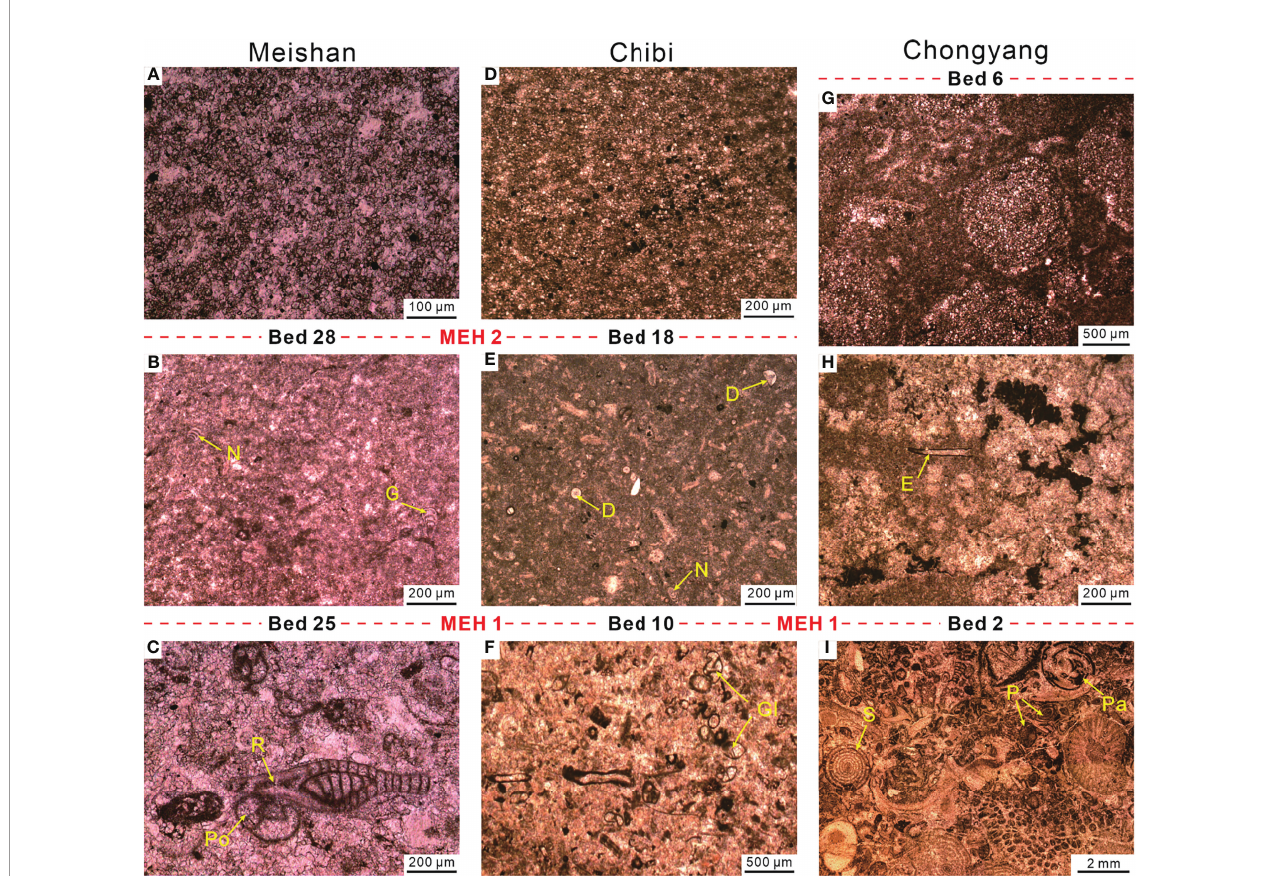
FIGURE 13 | Comparison of foraminifera features between Meishan (A – C) , Chibi (D – F) , and Chongyang (G – I) sections. (A) Micrite of Bed 29 with abundant pyrites but no fossil fragments. (B) Micrite of Bed 27a with few foraminifera. (C) Packstone of Bed 24, including abundant foraminifera and some algae fragments. (D) Marlstone of Bed 20 contains abundant pyrite. (E) Marlstone of Bed 13 contains few foraminifera. (F) Packstone of Bed 5 contains ca. 30% of algae and foraminifers. (G) Oolites of Bed 5. (H) Microbialite of Bed 3 containing few foraminifers and calci fi ed cyanobacteria. (I) Grainstone of Bed 1, including over 80% bioclastic. D, Diplosphaerina ; E, Earlandia ; G, Geinitzina ; Gl, Globivalvulina ; N, Nodosaria ; P, Palaeofusulina ; Pa, Paraglobivalvulina ; Po, Poatendothyra ; R, Reichelina ; S, Sphaerulina